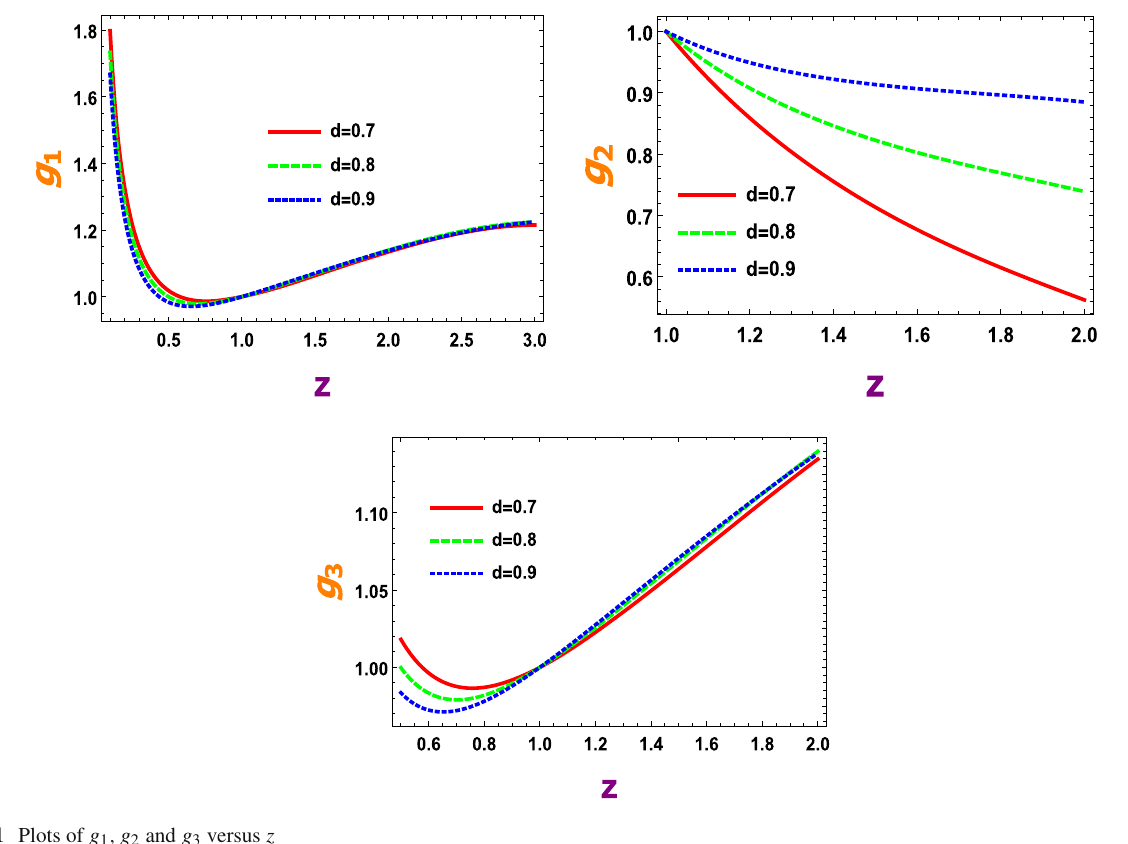
Fig. 1 Plots of g 1 , g 2 and g 3 versus